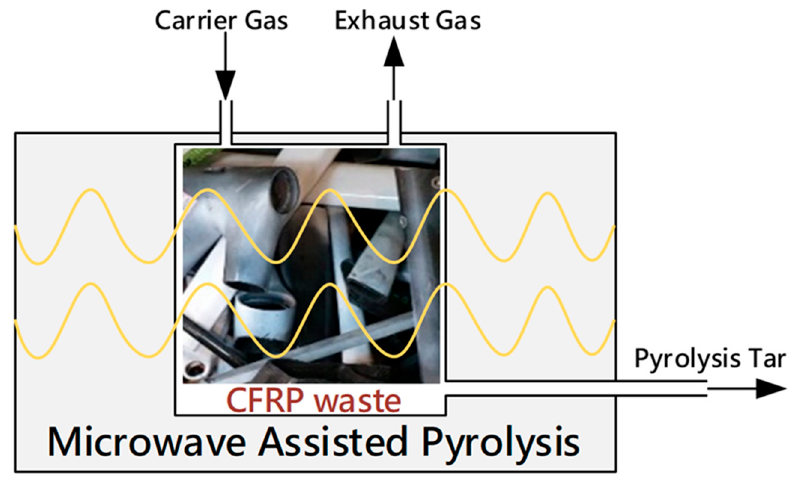
Figure 3. Microwave ‐ assisted pyrolysis instrument.